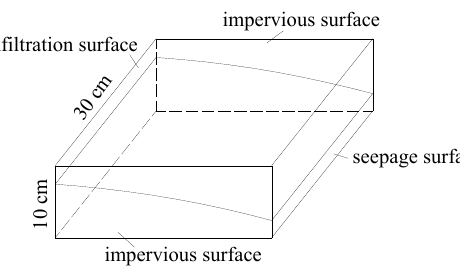
Figure 3. Schematic diagram of boundary conditions.